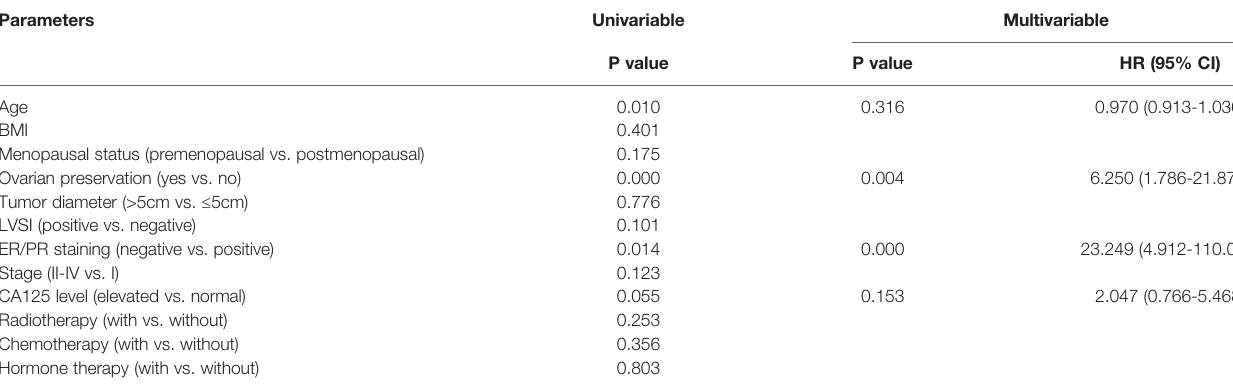
BMI, body mass index; LVSI, lymphovascular space involvement; ER, estrogen receptor; PR, progesterone receptor; HR, hazard ratio; CI, con fi dence